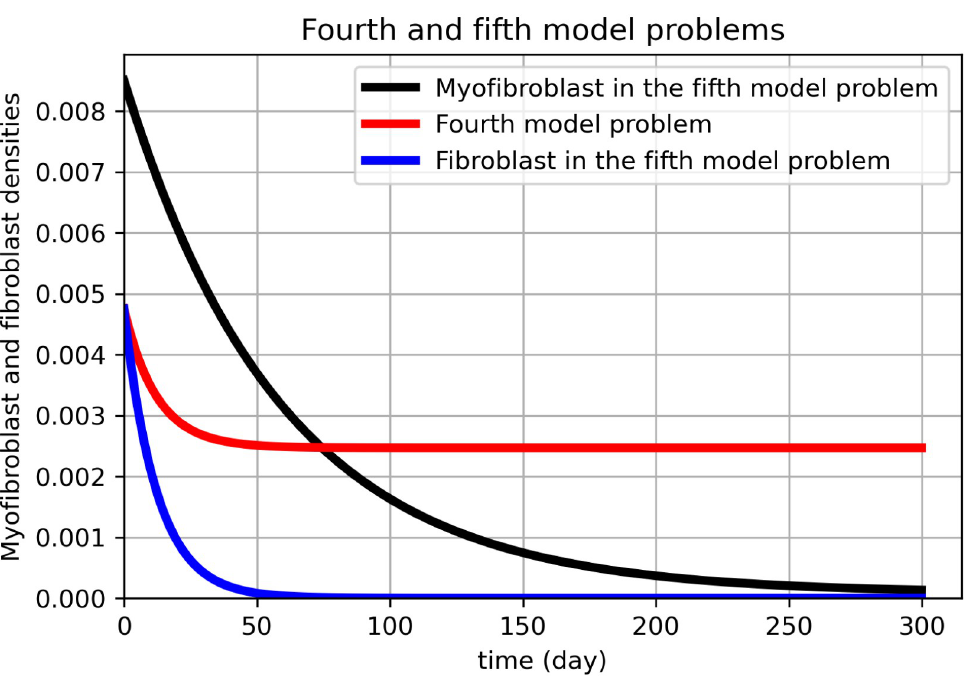
Fig 8. Novel model problem using myofibroblast and fibroblast for 64 nodes. In Fig 8, the fifth model problem (55)–(60) is solved by the technique proposed in this section with 64 nodes for the finite difference method (black color for myofibroblast and blue color for fibroblast). The fourth model problem for the fibroblast dynamical system (fibroblast PDE (57)) is solved (red). We compare Fig 7. (A) for 36 nodes with Fig 8 that is plotted for 64 nodes in the x-y plane. The graphs are almost the same. However, as it is shown in Fig 8, myofibroblast densities vanish in 290 days, while fibroblast density vanishes in 50 days. Since more discretization nodes give more accurate numerical solutions, we believe this solution is more reasonable. Thus the optimal strategy can get from calculations done by 64